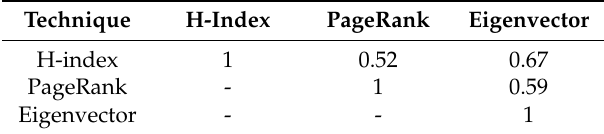
Table 9. OSim between PageRank, Eigenvector and the h-index.